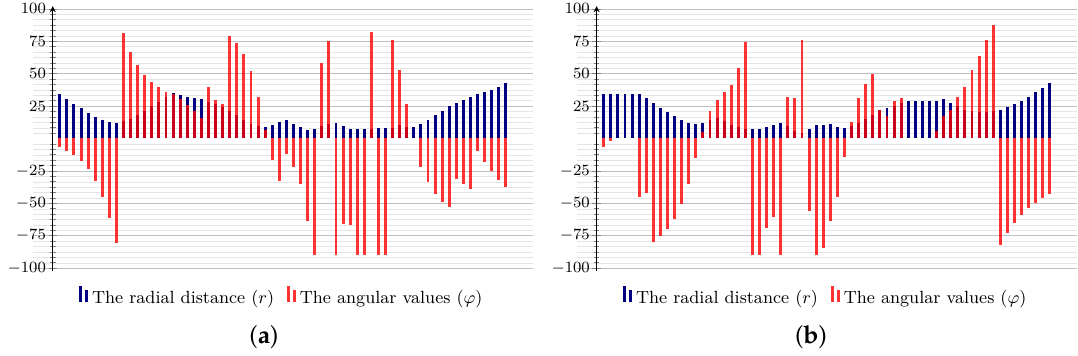
Figure 2. Shape descriptor profiles for letter (cid:188) : ( a ) the profile in the clockwise direction; ( b ) the profile in the anticlockwise